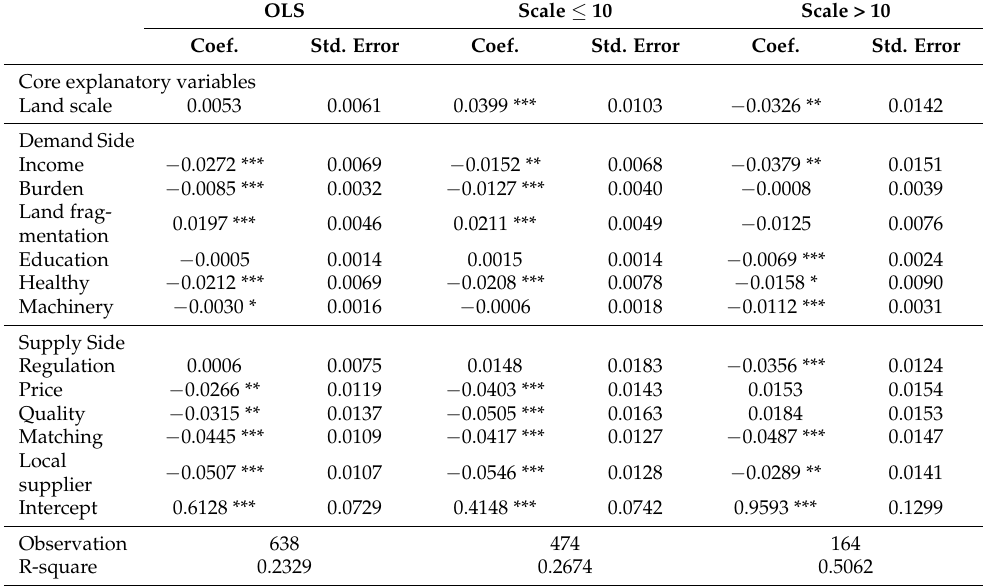
Table 6. The regression results of OLS and threshold effect model. OLS